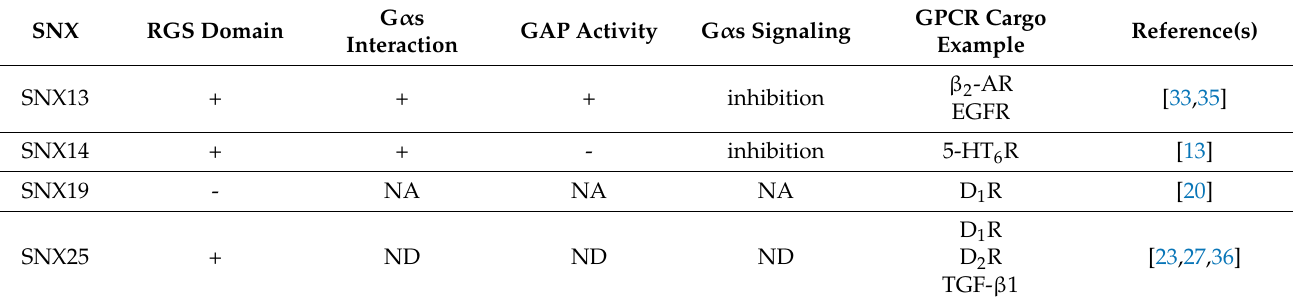
Table 3. Examples of RGS domain in SNX-PXA-RGS-PXC subfamily